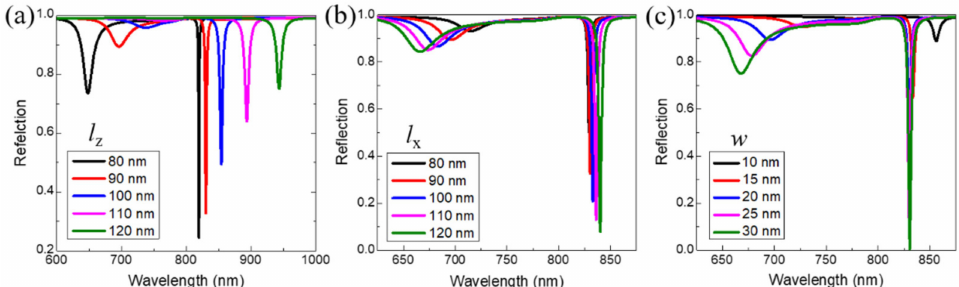
Figure 5. The calculated reflection spectra of the Au VSRRs on Au substrate ( a ) for different prong length l z ( b ) for different length of base rod l x at normal incidence and ( c ) for different width w of the Au split-ring resonators.